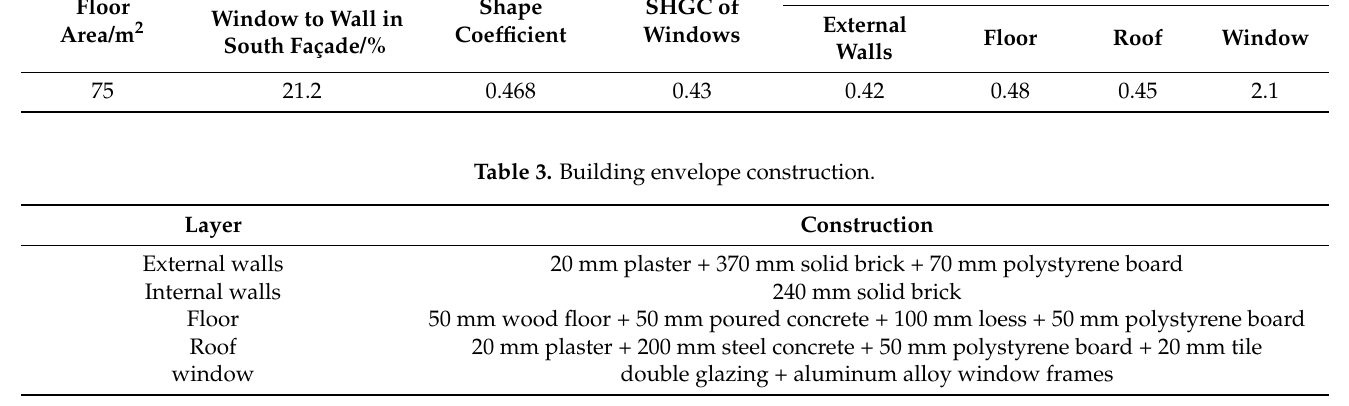
Table 3. Building envelope construction. Table 4. Dimensions of the solar wall